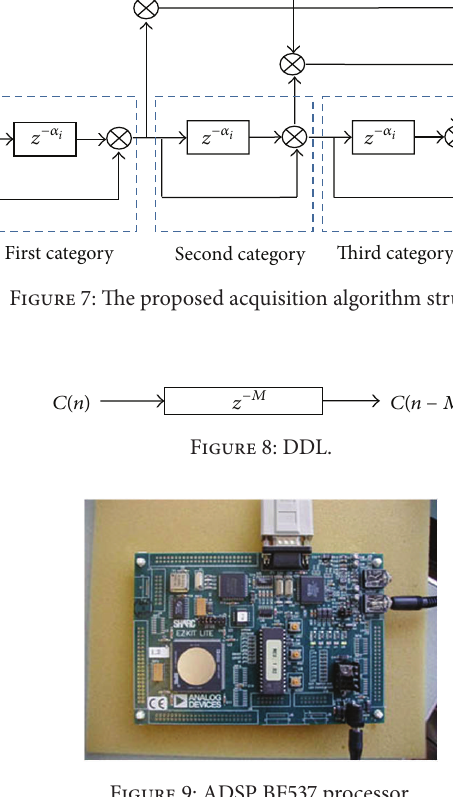
Figure 9: ADSP BF537 processor.